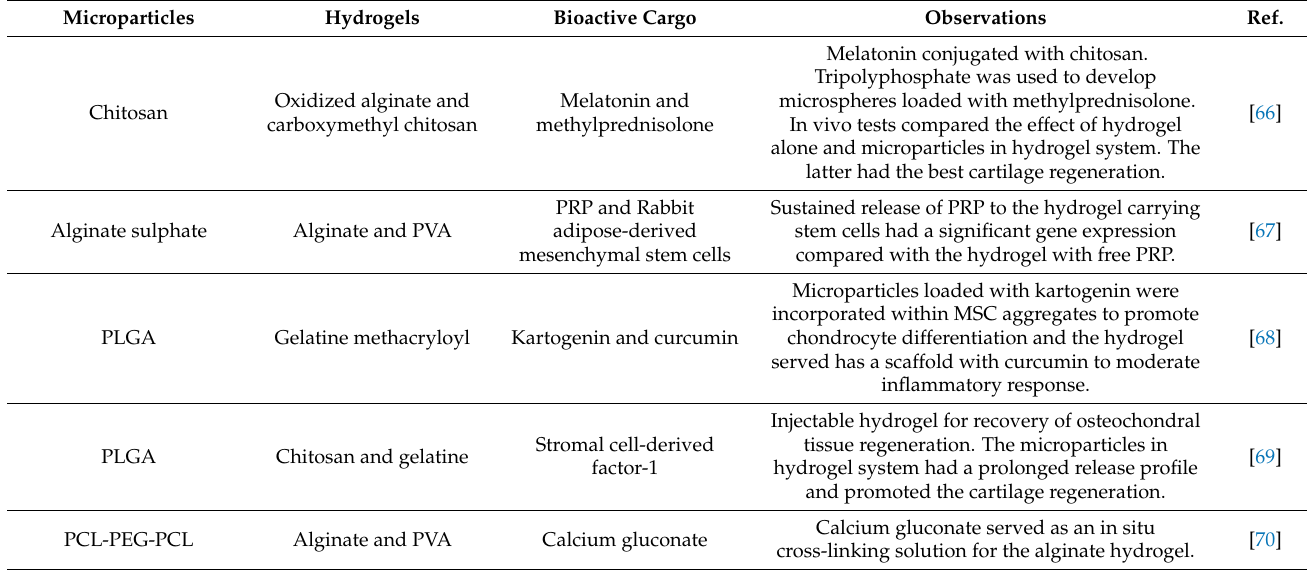
Table 4. Microparticles in hydrogel systems for cartilage defects